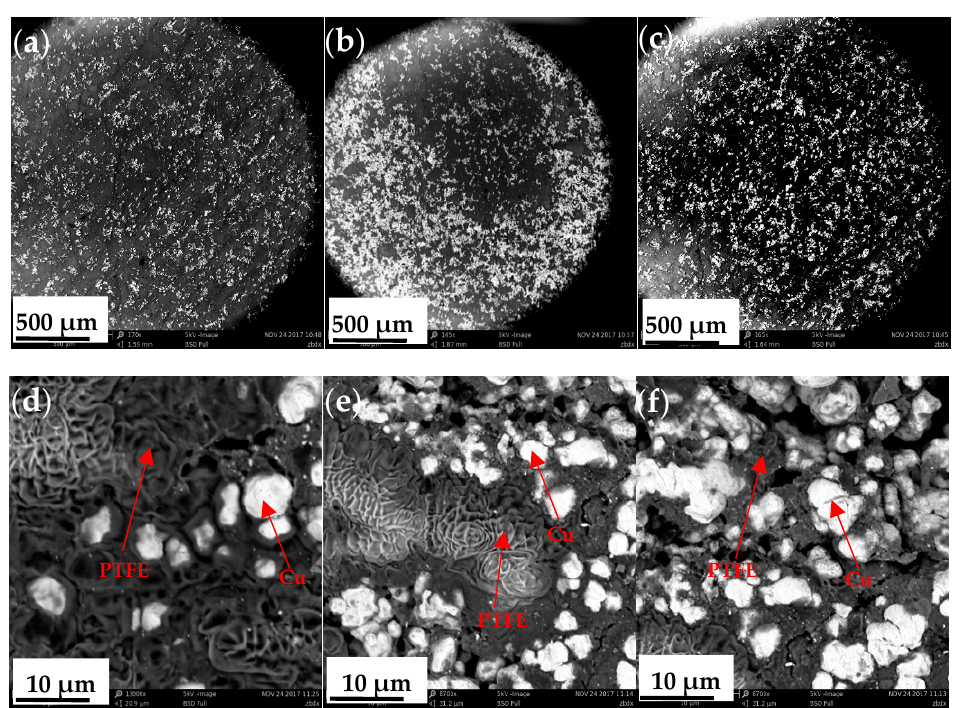
Figure 9. Backscattered SEM images of PTFE/Cu composites: ( a ) 500- µ m scale PTFE/Cu-1; ( b ) 500- µ m scale PTFE/Cu-2; ( c ) 500- µ m scale PTFE/Cu-3; ( d ) 10- µ m scale PTFE/Cu-1; ( e ) 10- µ m scale PTFE/Cu-2; ( f ) 10- µ m scale PTFE/Cu-3.